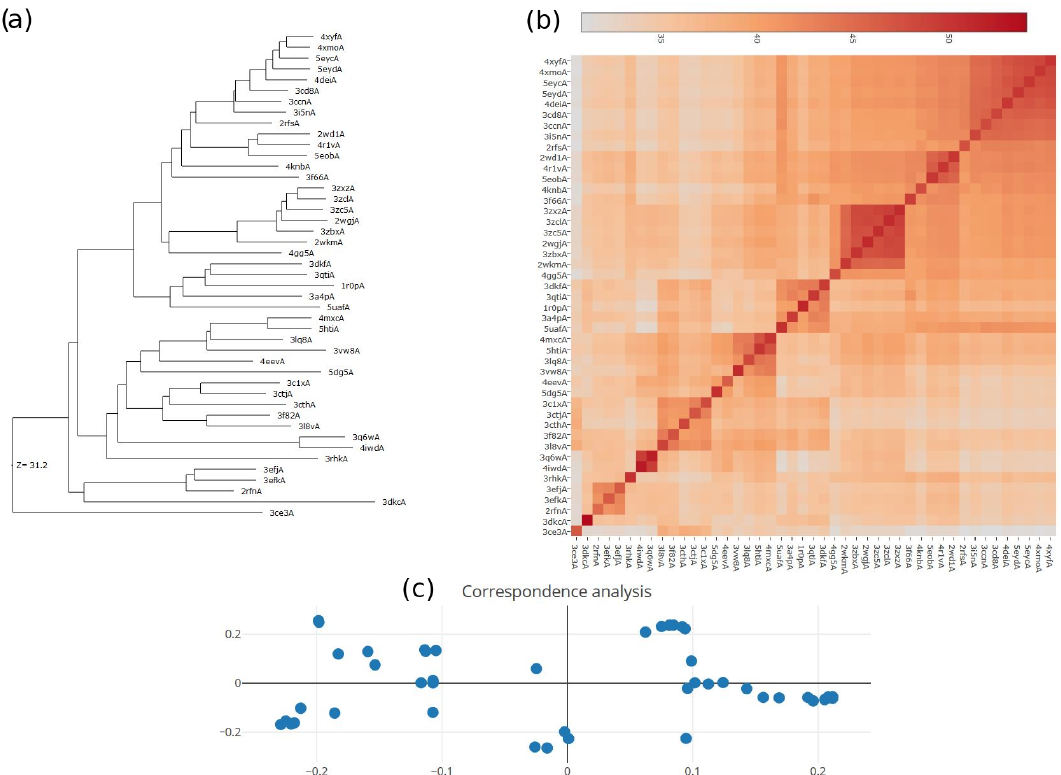
Figure 1. ( a ) Dendrogram showing the relationships between the 45 PDB conformers listed in Tables 2 and 3 and used to sample MET structure plasticity. ( b ) Similarity heat-map showing the relationships between the 45 PDB conformers and used to sample MET structure plasticity. The color scale corresponds to the Dali Z-score values. ( c ) Correspondence analysis of the 45 ensemble PDB-related conformers. This plot positions data points with the most similar structural neighborhoods near each other according to a multidimensional scaling